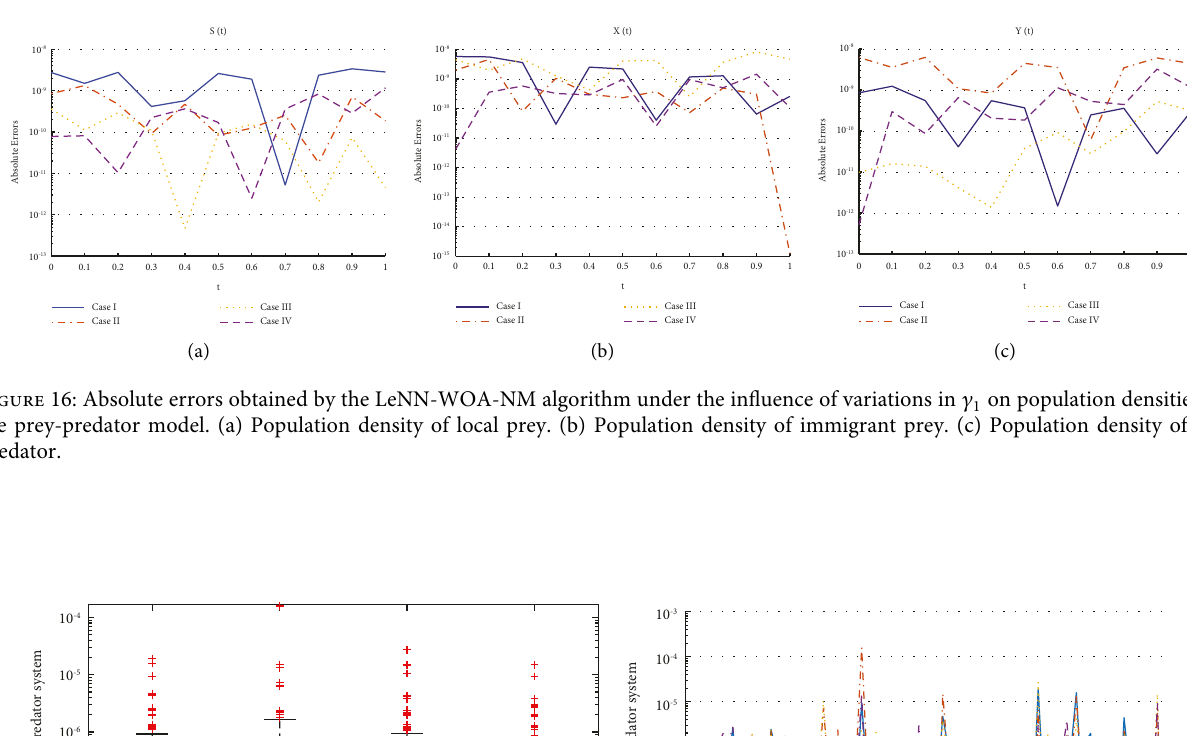
on population densities of 1